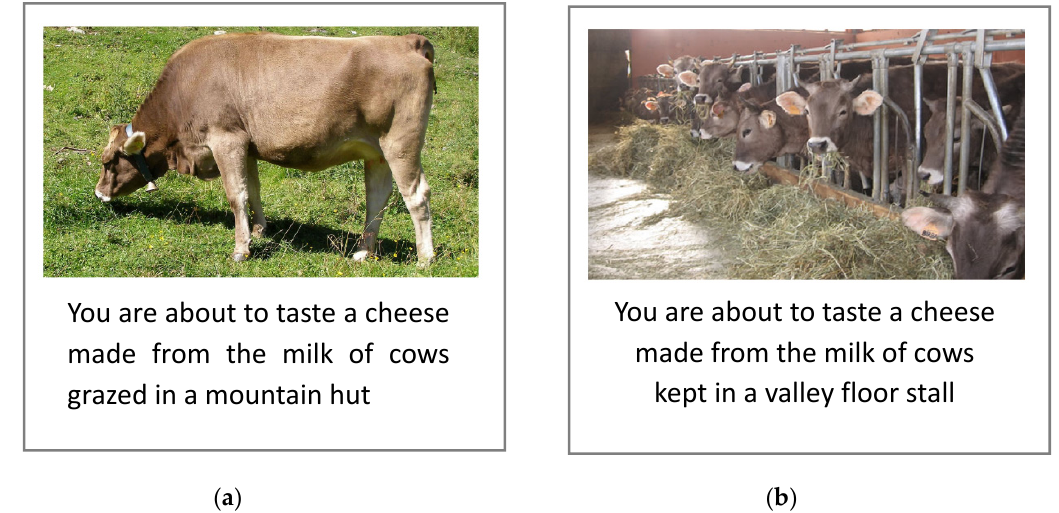
Figure 1. Examples of the screen used in the conjoint study: ( a ) The information about mountain pasture cheese; and ( b ) the information about cheese made with milk from cows reared in valley floor stalls.